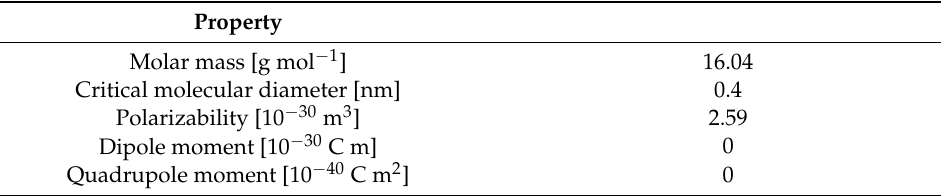
Table 4. Thermodynamic and structural properties of methane [60,61].